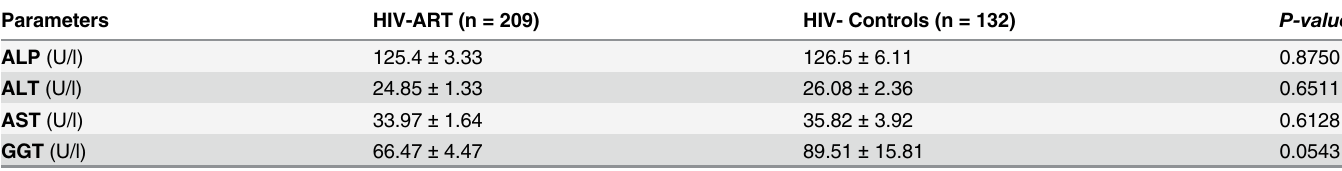
Table 2. Biochemical characteristics (hepatic enzymes) of study participants. Parameters